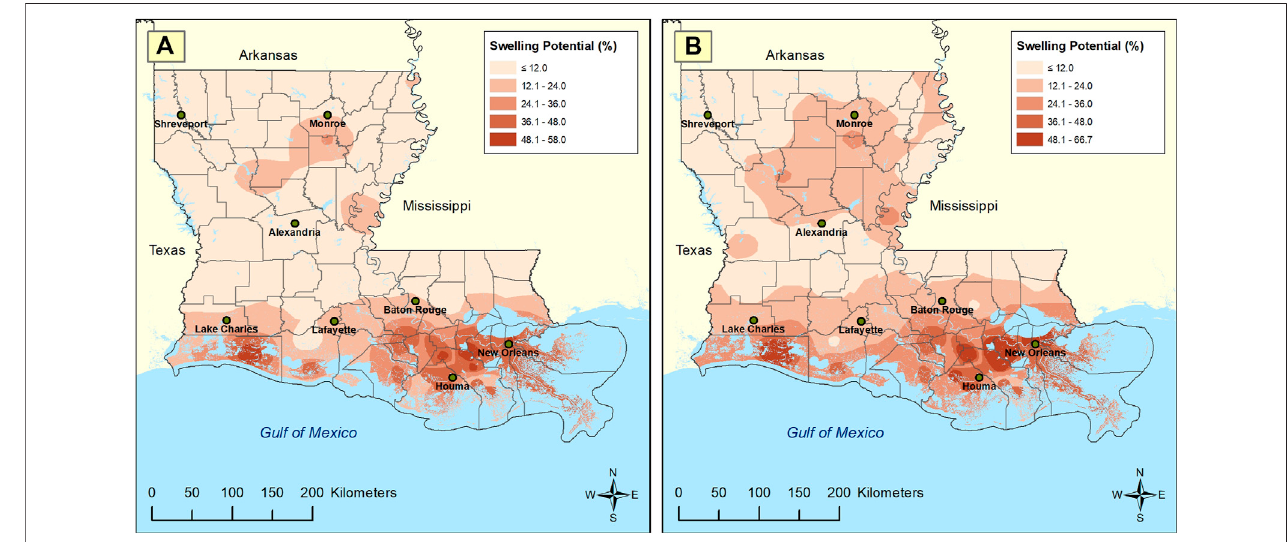
FIGURE 1 | Swelling potential in Louisiana: (A) historical, and (B) projection for 2050.